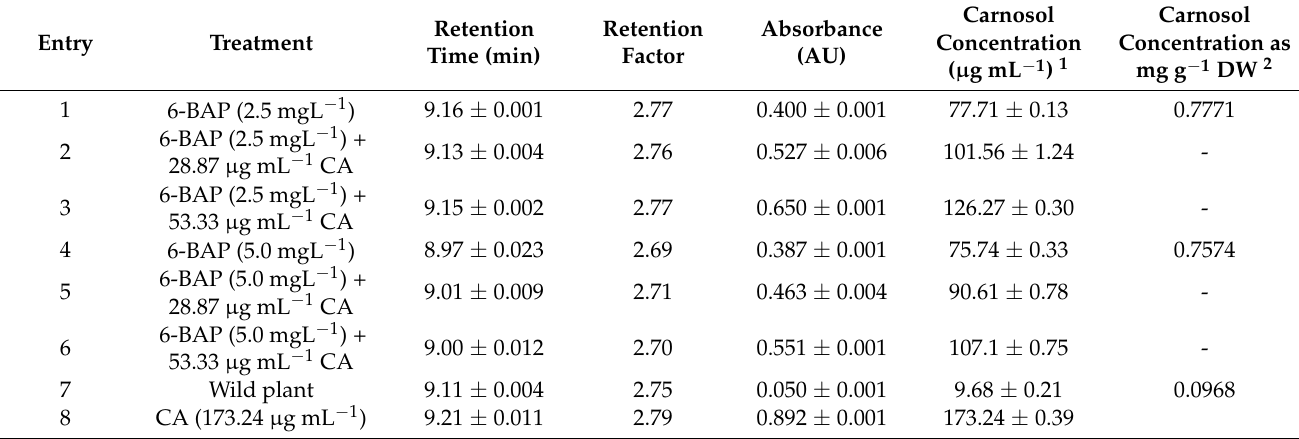
Table 5. Content of carnosol (CA) in the acetonic extracts of wild plant and callus samples of R. officinalis